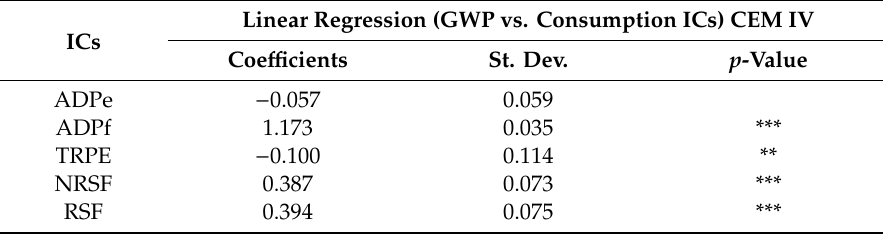
Table 14. AIC selection model (GWP vs. Consumption ICs)—CEM IV.